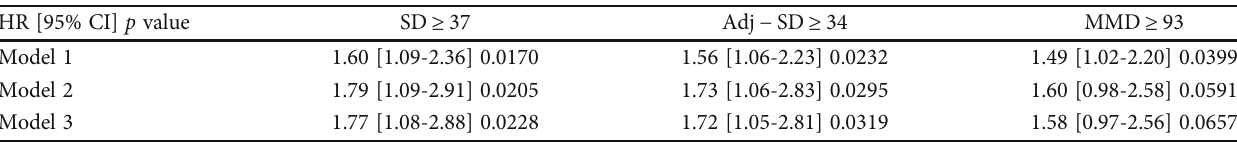
Table 4: Multivariate Cox ’ s proportional hazard regression model for the association between postprandial TG variability and the incidence of